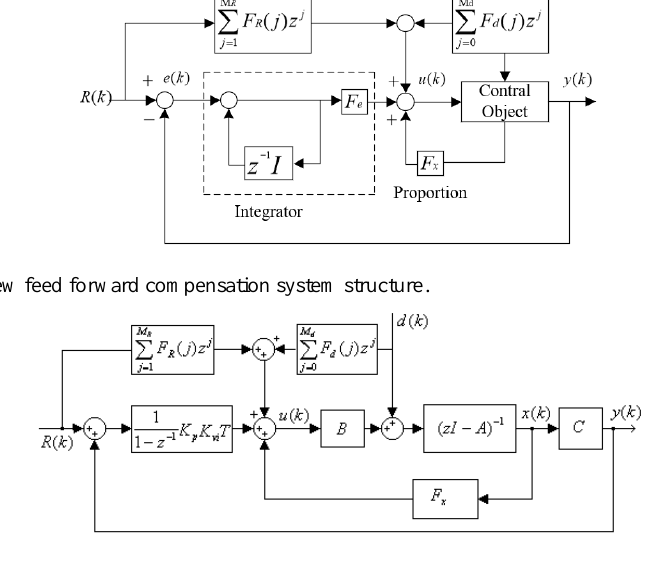
Fig. 5. Preview control block